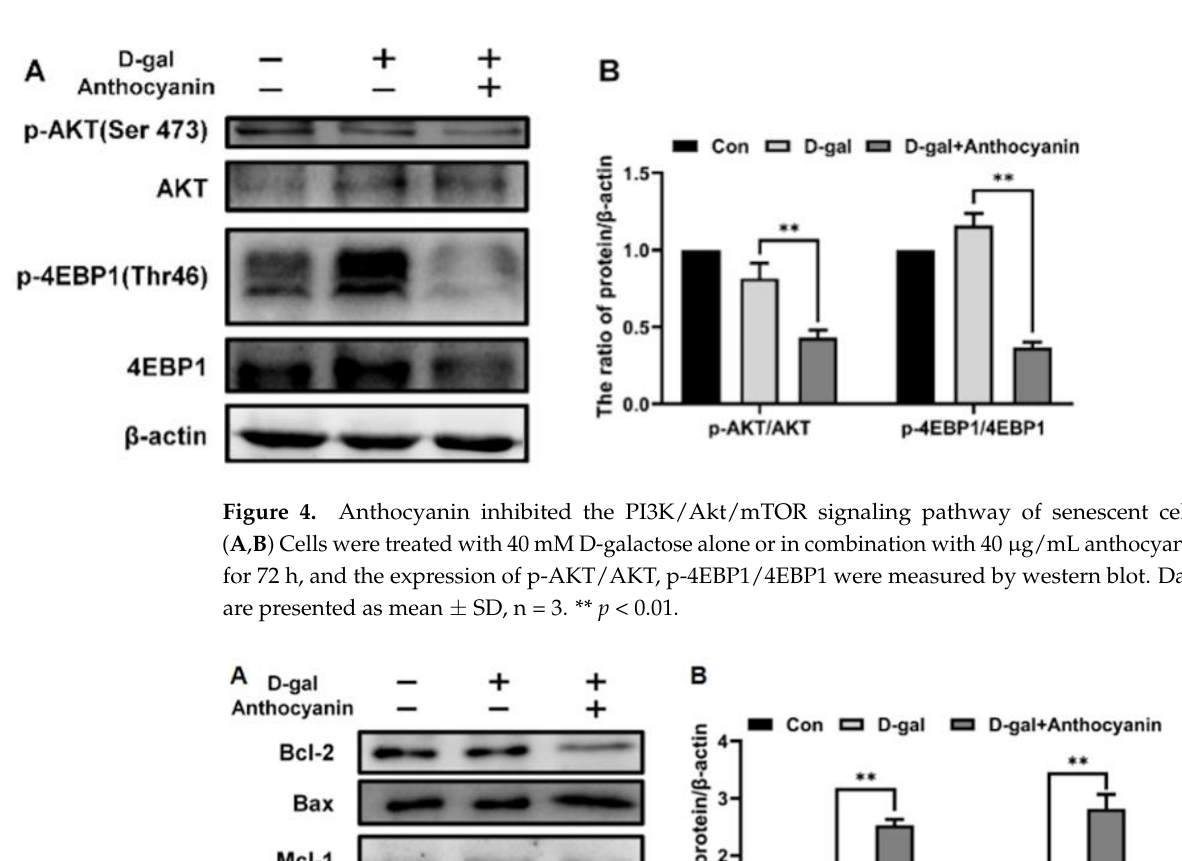
Figure 4. Anthocyanin inhibited the PI3K/Akt/mTOR signaling pathway of senescent cells. ( A , B ) Cells were treated with 40 mM D-galactose alone or in combination with 40 μg/mL anthocyanin for 72 h, and the expression of p-AKT/AKT, p-4EBP1/4EBP1 were measured by western blot. Data are presented as mean ± SD, n = 3. ** p < 0.01.